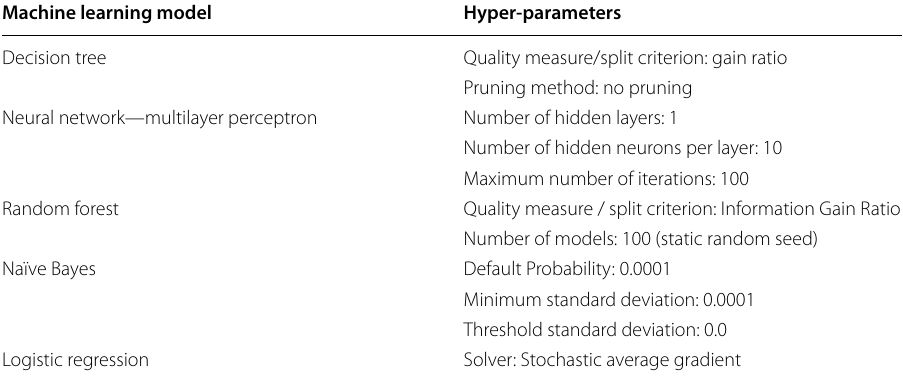
Table 3 Hyper-parameters used in the Machine learning models Machine learning